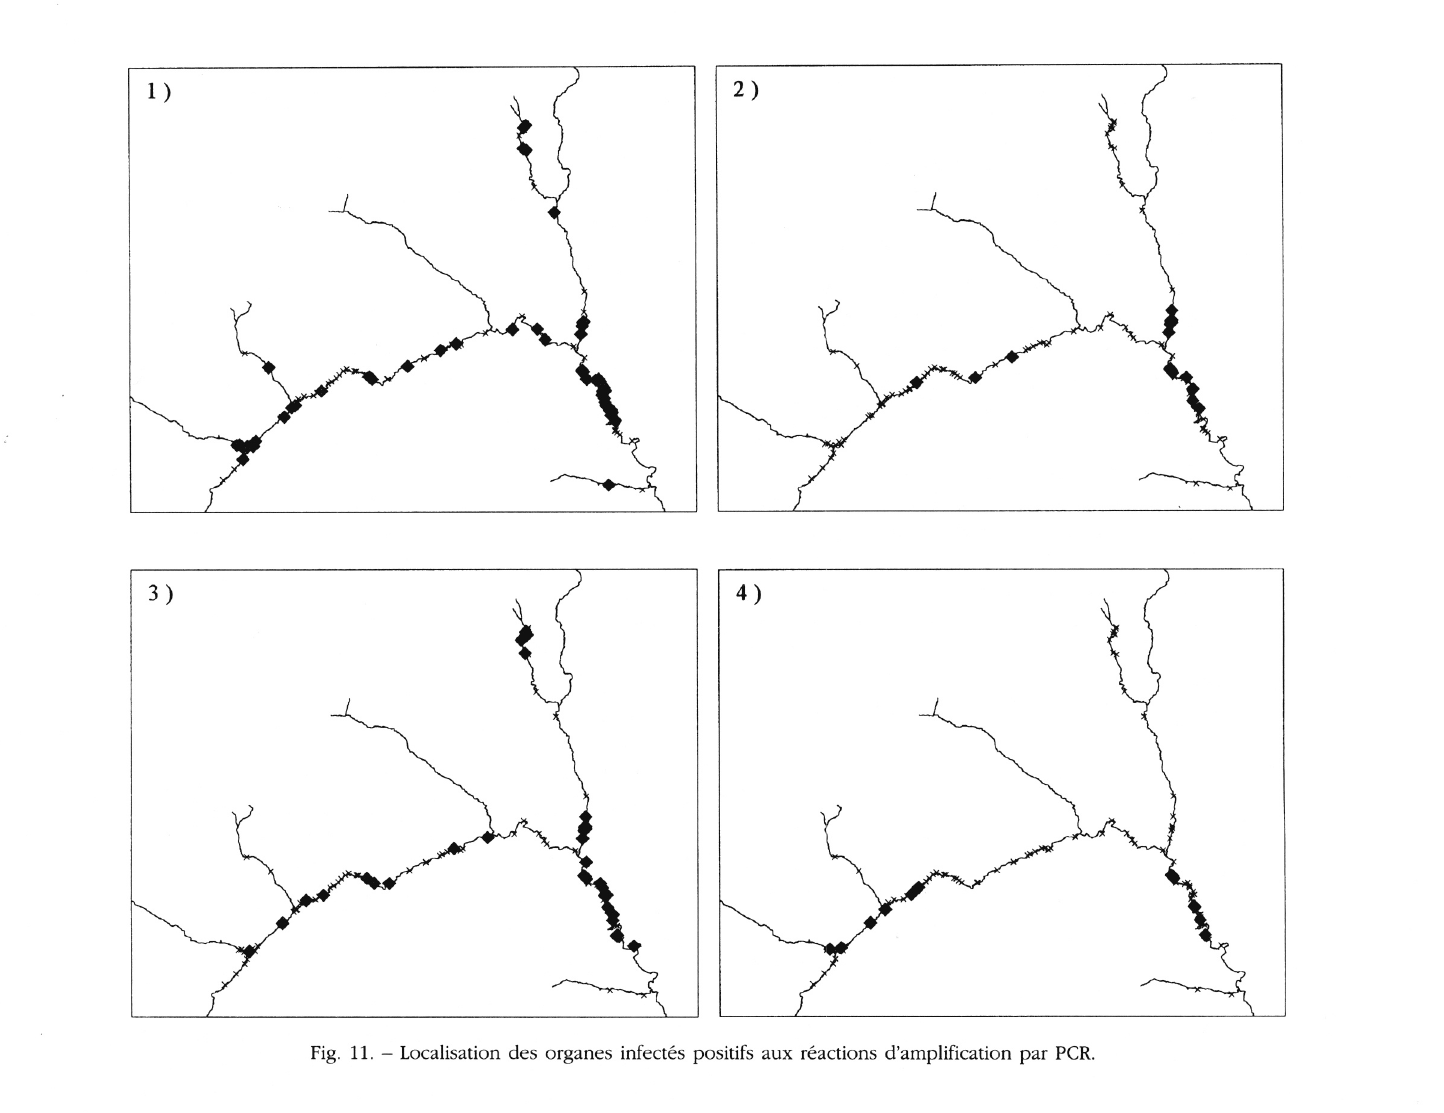
Fig. 11. - Localisation des organes infectés positifs aux réactions d’amplification par